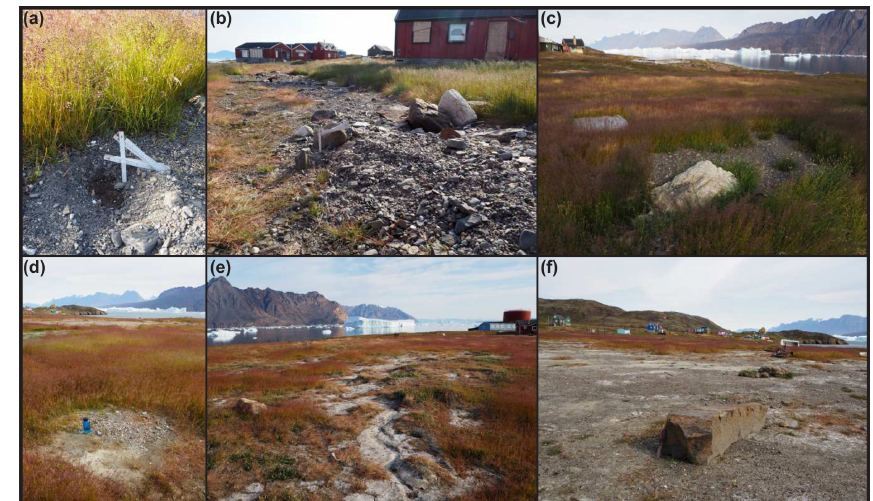
Figure 5. Examples of tsunami deposits preserved in Nuugaatsiaq 2 years after the event. (a) Ca. 4–6cm thick cover of marine gravels covering grass vegetation. (b) Up to 10cm thick layer of tsunami deposits eroded from local beach and deposited on road and grass vegetation. (c) Melt-out material from icebergs (gravels and mud) and ca. 100cm long boulder thrown onshore by the tsunami. (d) Deposits melted out from an iceberg washed on shore by waves; (e) rills eroded in soil and tsunami deposits by returning wave. (f) Over 100cm long boulder moved by waves on the thin layer of gravels and eroded soil deposits. Note salty surfaces and eroded tundra rafts in the